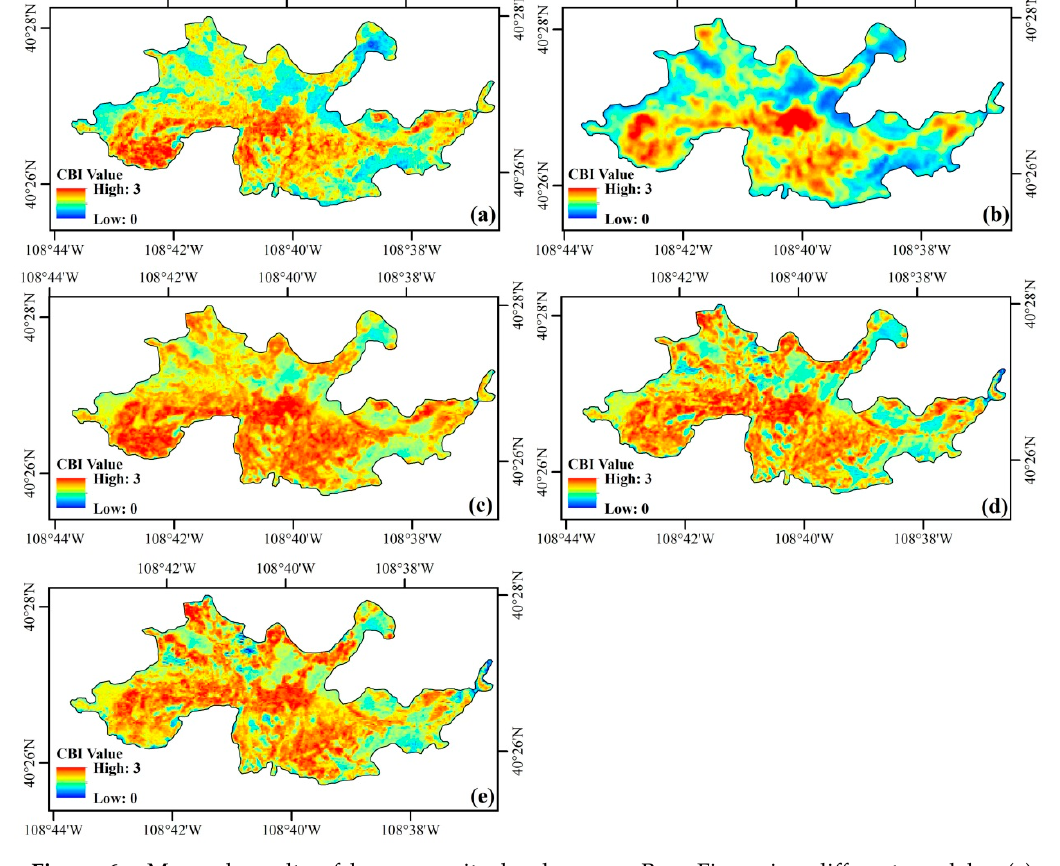
Figure 6. Mapped results of burn severity levels across Bear Fire using different models: ( a ) ∆ NDVI-based regression model; ( b ) ∆ LST-based regression model; ( c ) ∆ NBR-based regression model; ( d ) SVR model; and ( e ) SSTCA-SVR model.